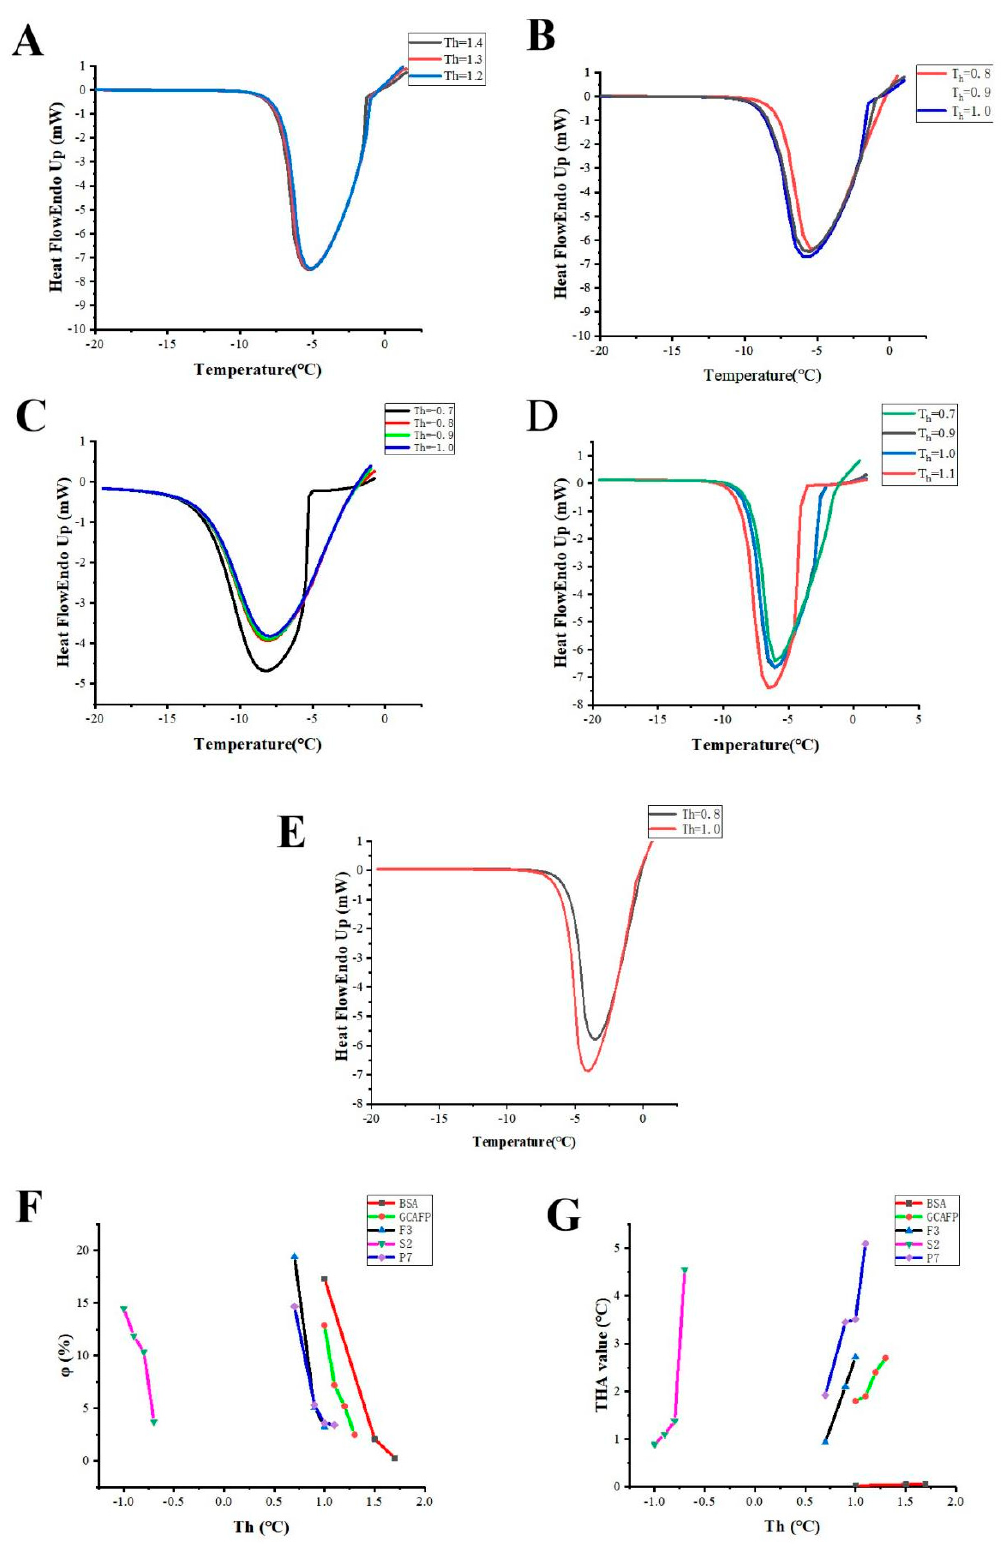
Figure 4. The thermal hysteresis activity (THA) of F2, S2, and P7 compared with GCAFP (original hydrolyzed Ctenopharyngodon Idella scales), as well as the negative control of BSA (AFP-free protein). The differential scanning calorimetry (DSC) typical curves of the freezing and melting processes at different hold temperatures (T h ) for ( A ) GCAFP, ( B ) F2, ( C ) S2, ( D ) P7, and ( E ) BSA. The T h values of the curves in ( A ) were 1.1, 1.2, and 1.3 ◦ C, respectively. The T h values of the curves in ( B ) were